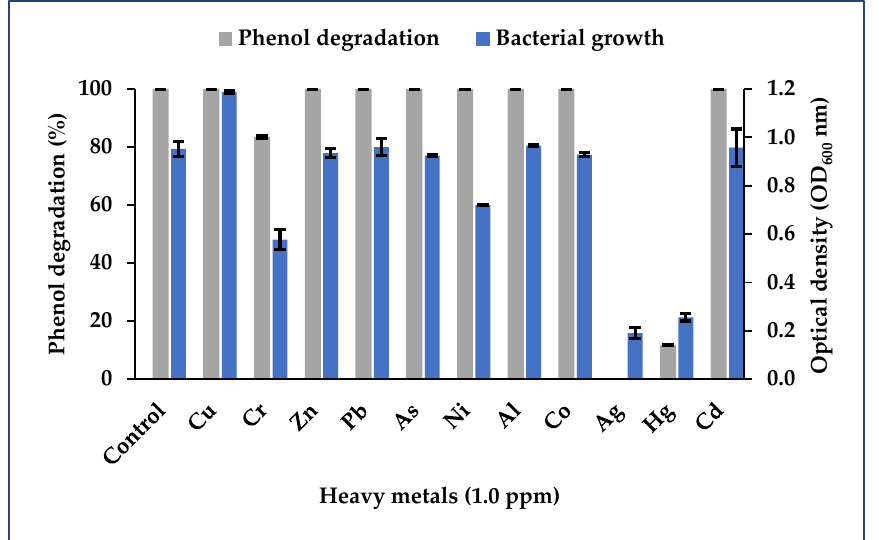
Figure 4 . Phenol degradation and growth of Arthrobacter sp. strain AQ5-06 in the presence of 1.0 ppm concentrations of different heavy metals. Error bars represent the mean ± standard deviation of three replicates.